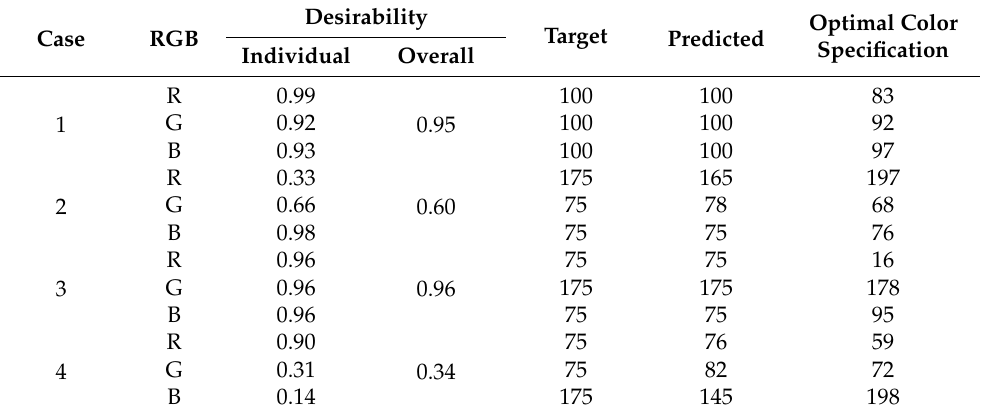
Table 3. Optimal color specifications determined by individual and overall desirability values.